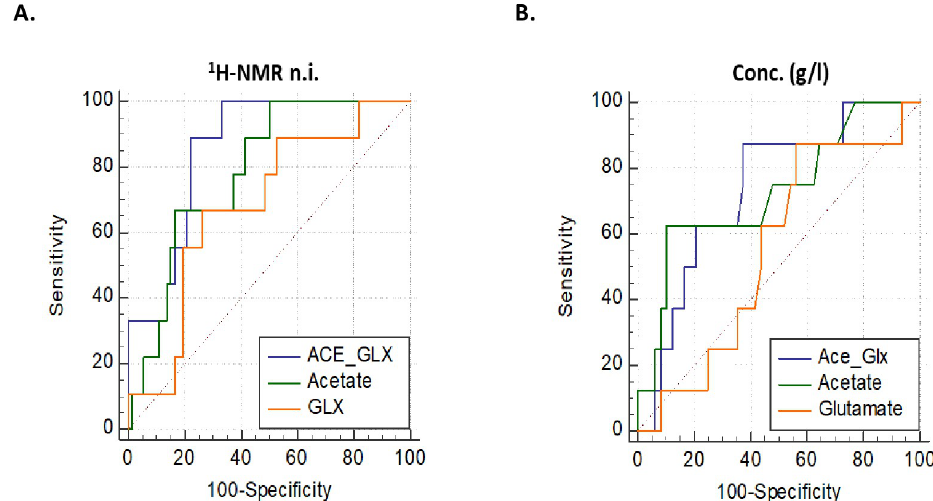
Fig 2. Receiver operating characteristic curve analysis of cervicovaginal fluid metabolites in predicting delivery within 2 weeks of presentation with symptoms of preterm labour. (A) 1 H-NMR-derived acetate/glutamate ratio (Ace/Glx, AUC = 0.86, 0.76–0.93), Acetate (AUC = 0.78, 0.68–0.87) and Glutamate (AUC = 0.68, 0.57–0.78); (B) Metabolite concentrations measured by enzyme-based spectrophotometry: Ace/Glx (AUC = 0.74, 0.61–0.85), Acetate (AUC = 0.73, 0.59–0.84) and Glutamate (AUC = 0.54, 0.41–0.68). n . i ., normalised integral.